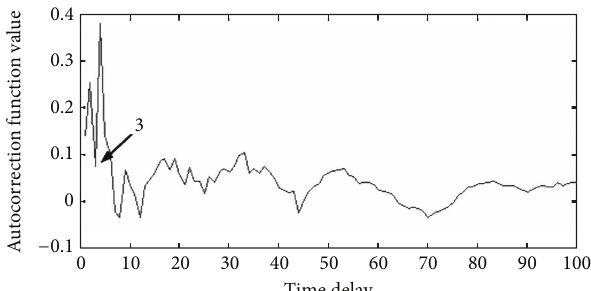
Figure 9: Selection of the delay time by the autocorrelation function value of LTSA1.